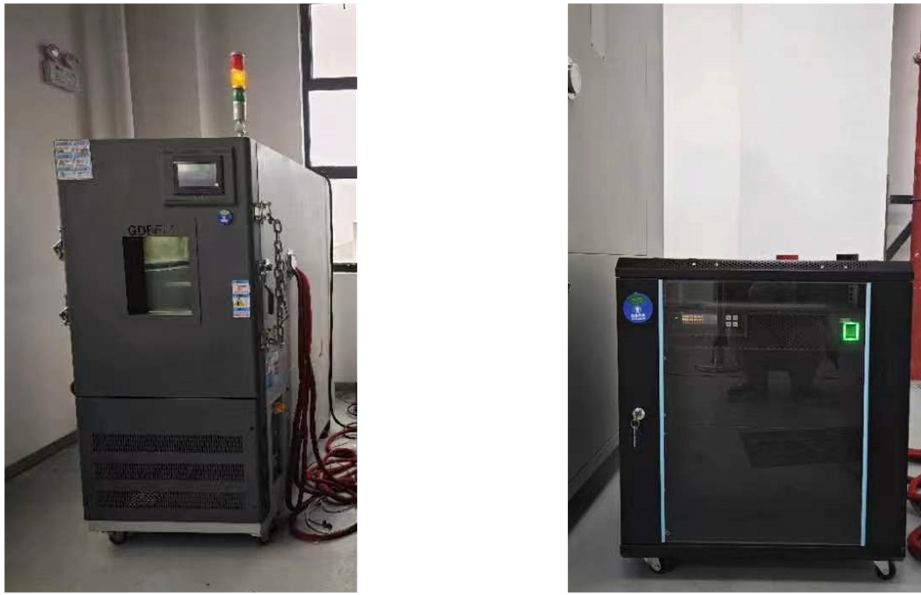
Figure 10. Equipment t emperature cycle test.